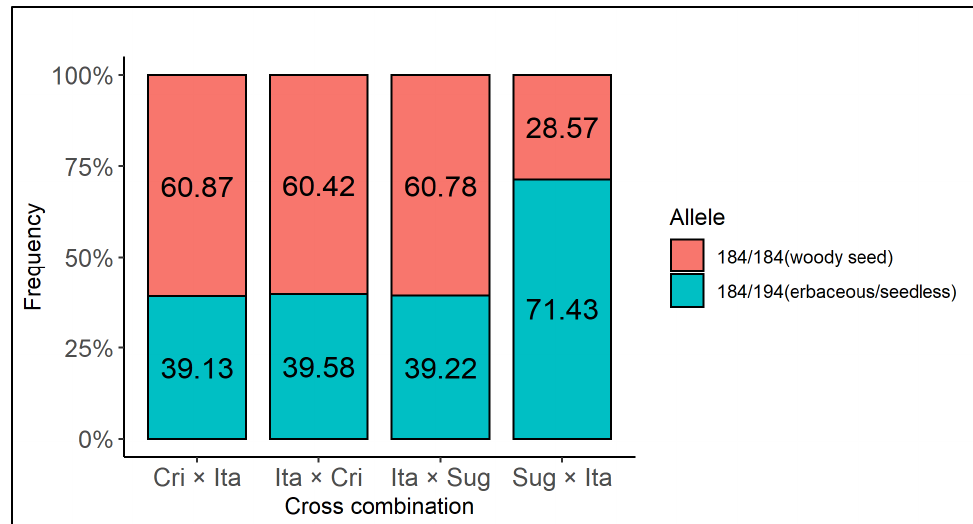
Figure 6. Distribution of allele p3_VvAGL11 in hybrids of 4 cross combinations in which the pa- rental lines are used both as maternal and paternal line. lines are used both as maternal and paternal line.